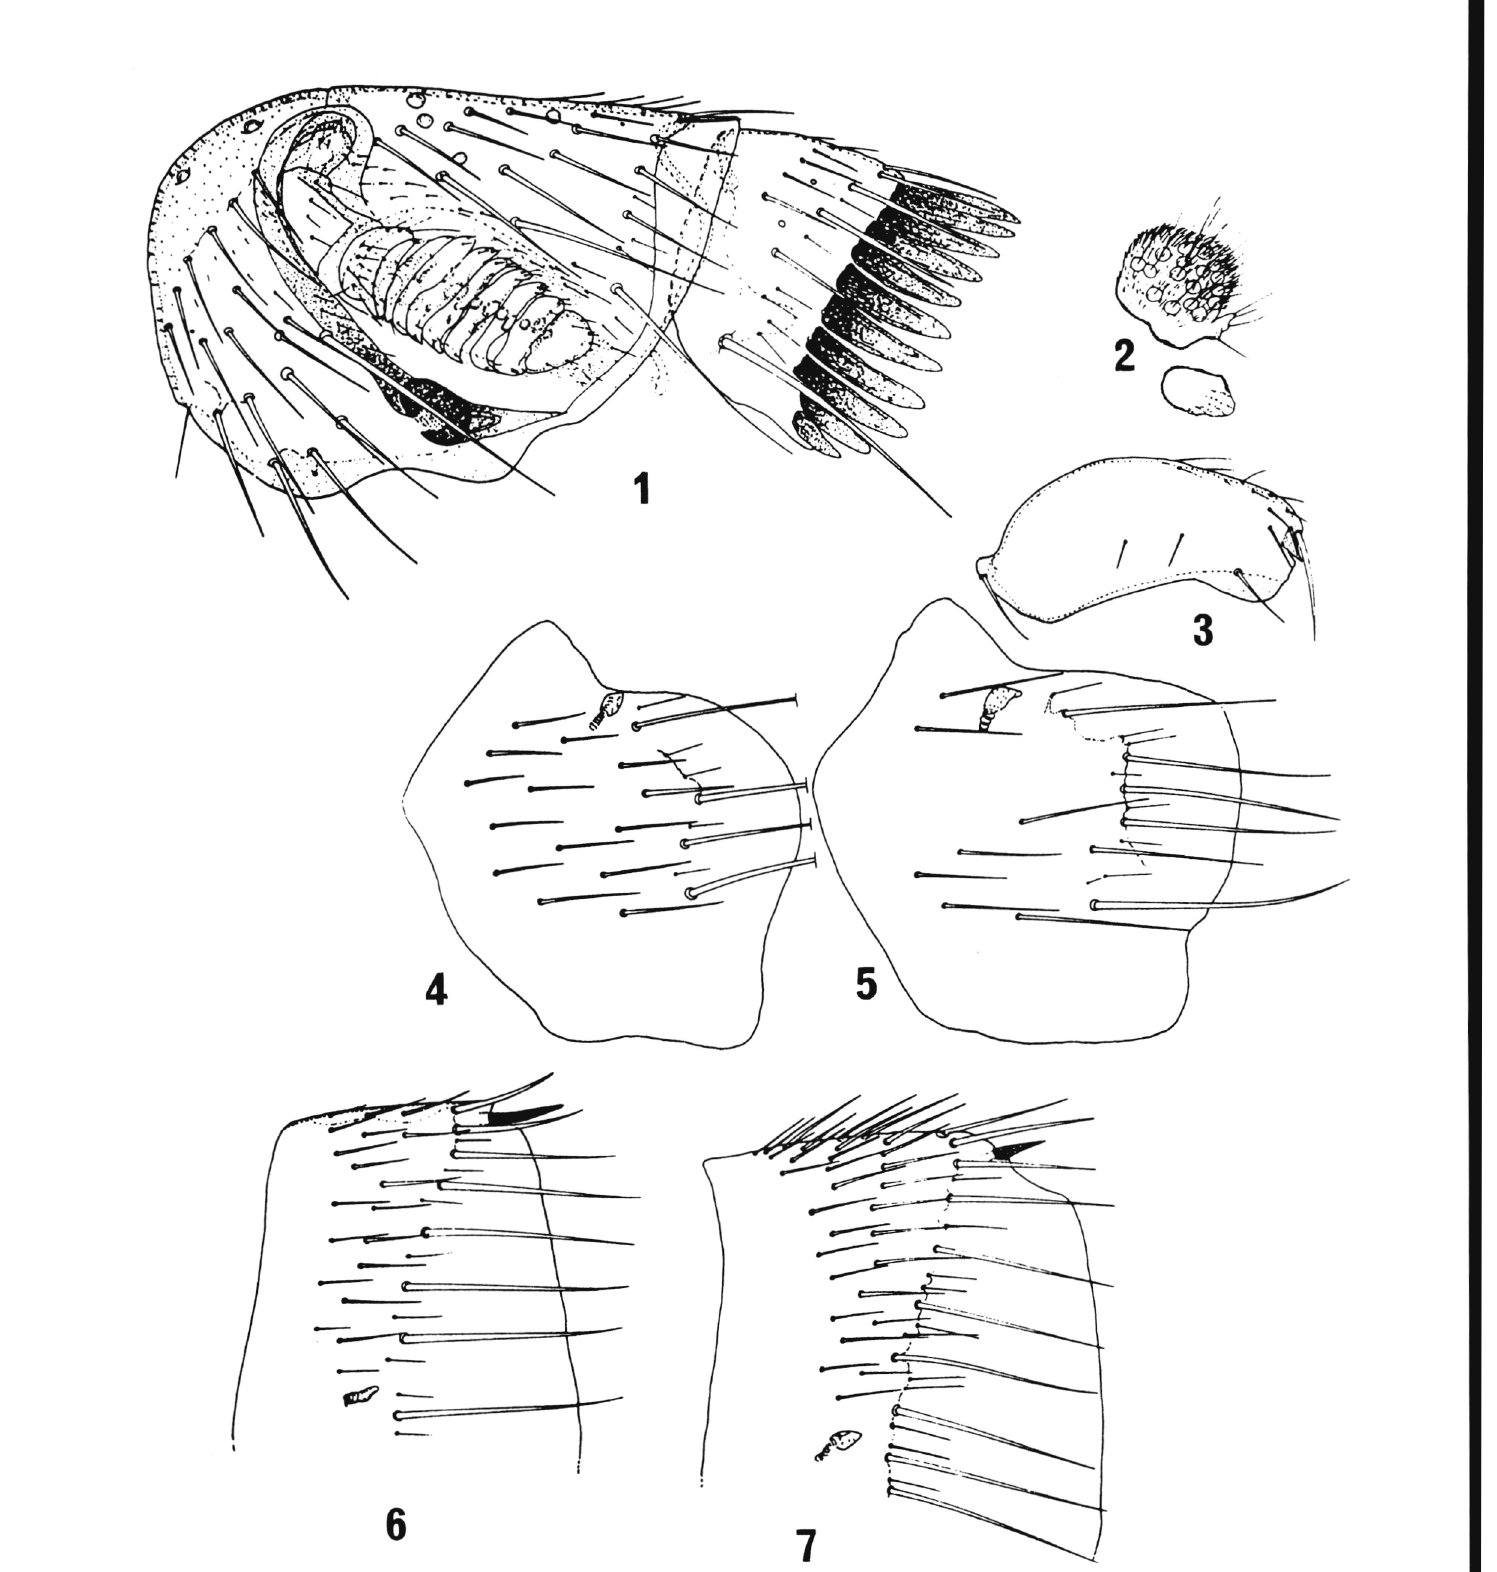
Figs 1-7. - Gymnomeropsylla Durden & Beaucournu, n. gen. 1: G. bunomydis Beaucournu & Durden, n. sp., head and pronotum (holo­ type male); 2: G. bunomydis, sensilium and subsensilial sclerite (in situ) (holotype male); 3: G. bunomydis, femur I (holotype male); 4: G.